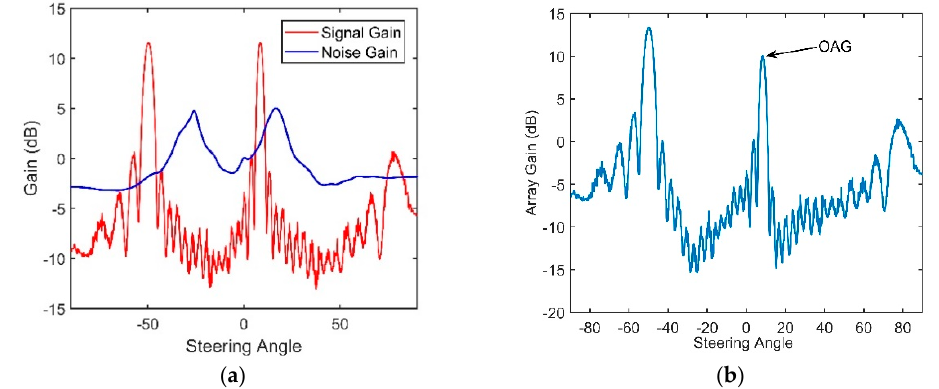
Figure 23. ( a ) The variation in the SG and NG with steering angles of CBF and ( b ) The variation of Optimal array gain with steering angles of CBF under a 2.4-km source range.